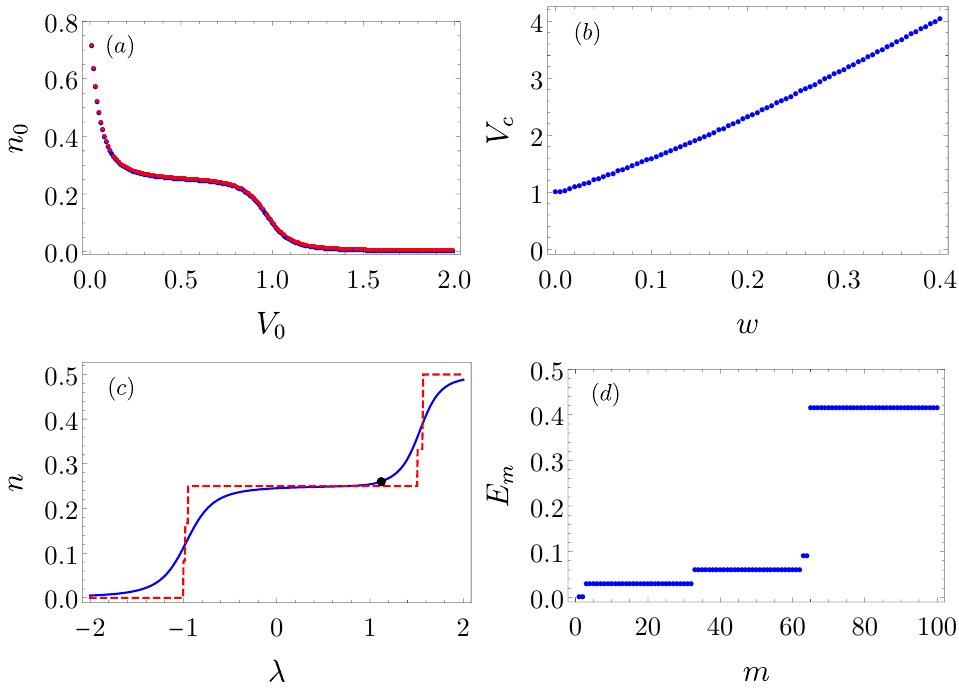
≃ 1.6 Figure 5: (a): Plot of n as a function of V for w = 0.1 and λ = 1 showing V c 0 0 for N = 12 (blue squares) and N = 16 (red circles). (b) Plot of V as a function of c = 2 showing the w for λ = 1. (c) Plot of n as a function of λ for w = 0.1 and V 0 plateau for n and the position of the transition (black circle).(d) The eigenenergies E of H V , measured from the ground state energy, as a function of m (for m ≤ 100) m eff for λ = 1, w = 0 and N = 24 showing the near-degenerate manifold. The two degenerate ground states at w = 0 correspond to two Fock states where the Rydberg excitations occur alternately on even sites of ladders 1 and 2. All energies are scaled in units of ∆ . See text for